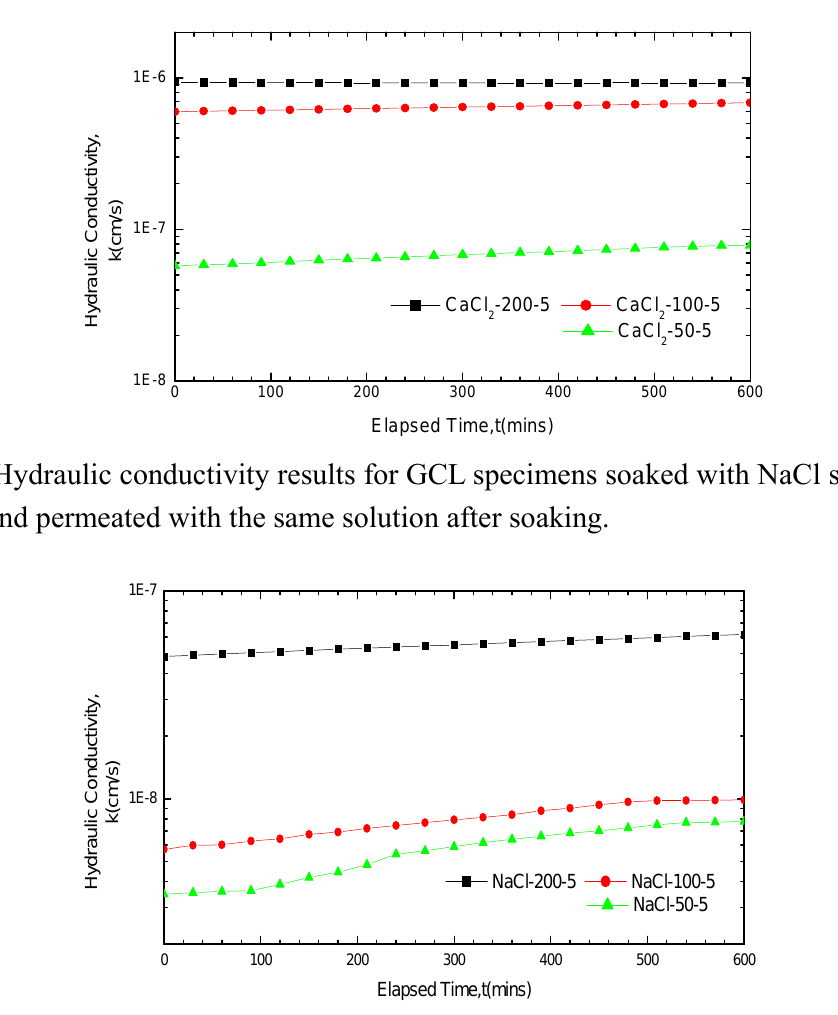
Figure 4. Hydraulic conductivity results for GCL specimens soaked with CaCl five days and permeated with the same solution after soaking.